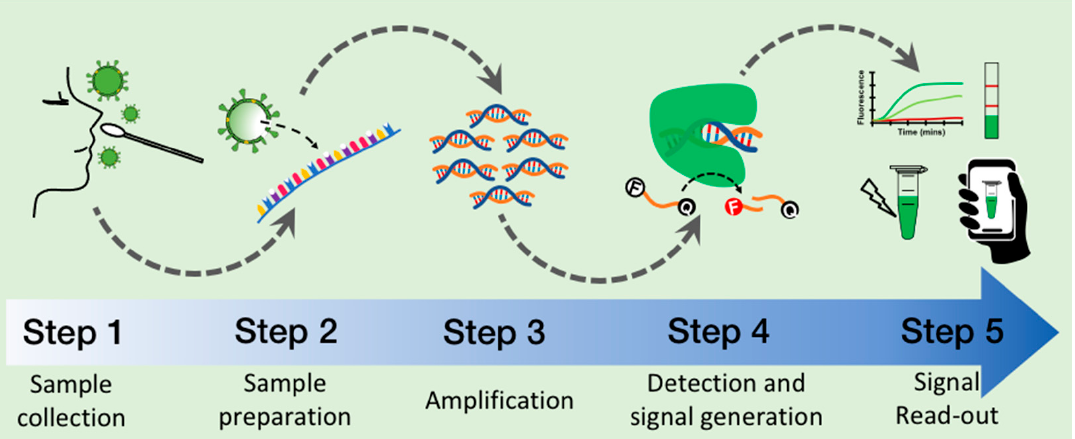
Figure 2. General workflow to detect SARS-CoV-2 with CRISPR-based test includes five general steps: (1) Clinical sample collection, (2) RNA preparation by extraction or release methods, (3) target sequence amplification, (4) target recognition and generation of molecular signal, and (5) signal read-out using fluorescence or lateral flow strips which could include cell phone detection.